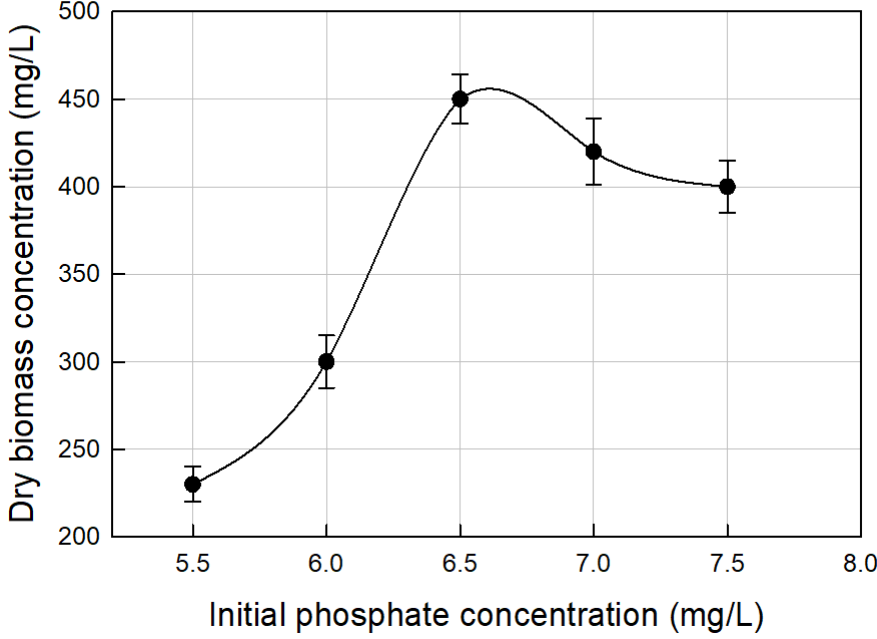
Figure 5. Dry cell mass concentration on day 15 in media with different initial phosphate (as NaH 2 PO 4  H 2 O) concentrations. Average values ± standard deviation of five replicates. (Initial nitrate and silicate concentrations were 1.75 mg L −1 (as NaNO 3 ) and 8.5 mg L −1 (as Na 2 SiO 3  9H 2 O), respec- tively, in all